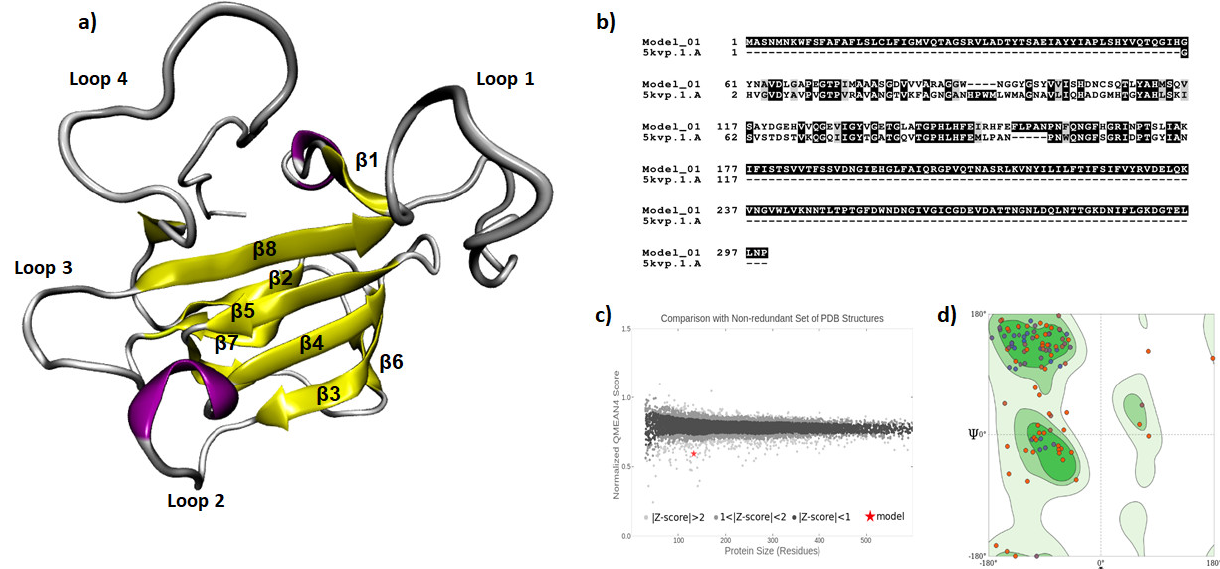
Figure 3 – Comparative modeling results for Zoocin A. (a) Model of zoocin obtained from Swiss-Model Workspace (Waterhouse et al. 2018) (b) alignment sequence of Zoocin N-terminus and with the Zoocin A from Streptococcus equi subspecies zooepidemicus strain 4881 (c) QMEAN plot for the model (d) Stereochemical quality of the model from homology modeling with Swiss-Model Workspace (Waterhouse et al.